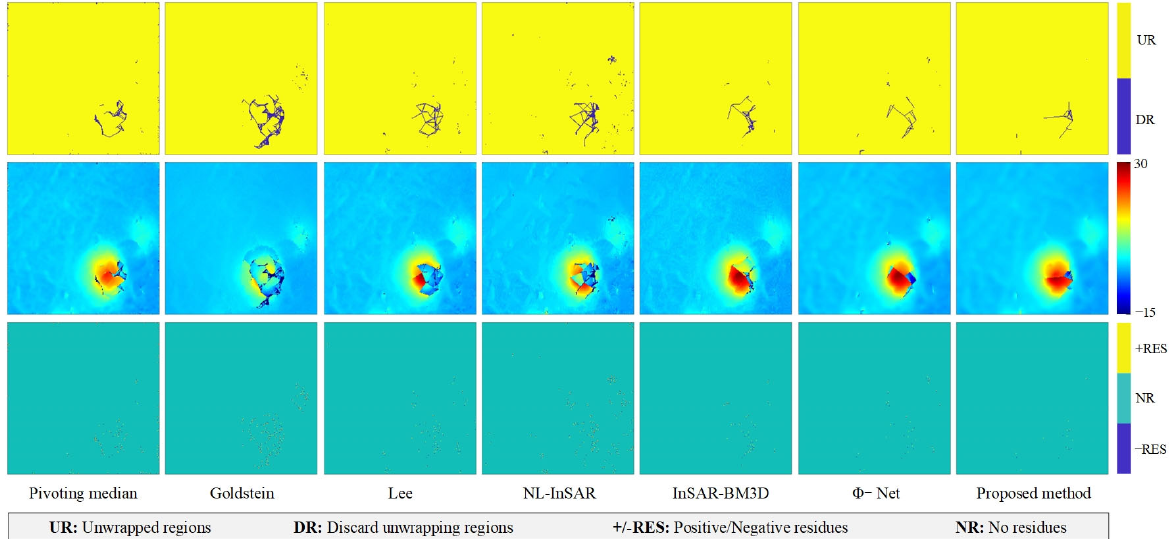
Figure 10. Phase unwrapping results for the case of the Jinchuan mine area in Section 3.3, that the first row is unwrappable area, the second row is unwrapping result. the third row is residues distribution. The unwrapped area image in the first row and the phase unwrapped image in the second row support the indirect evaluation of filtering quality. The residue images in the third row evaluate noise suppression capability.